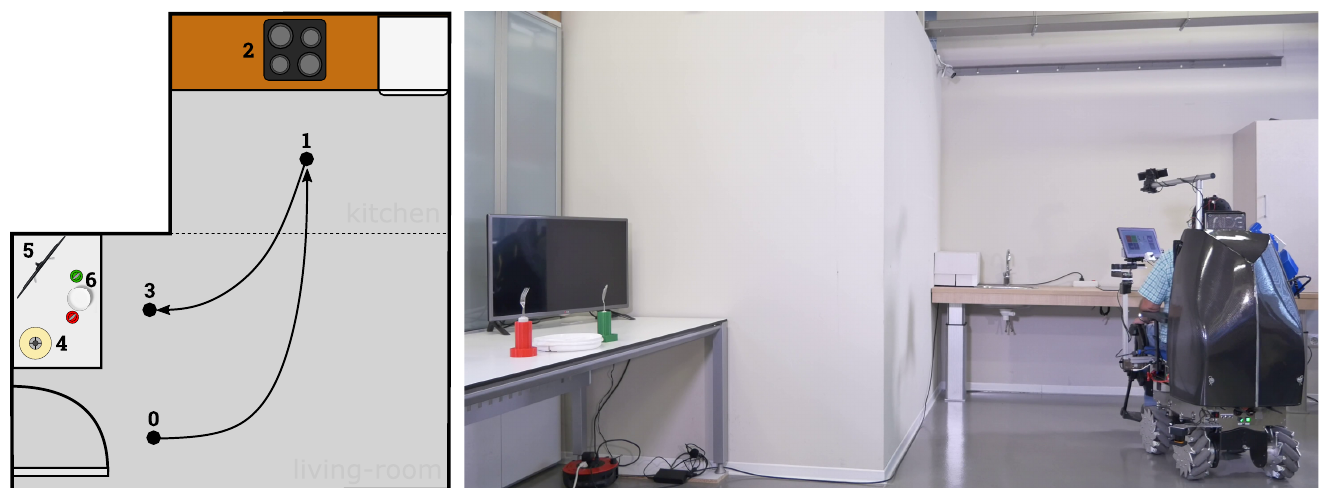
Figure 9. Simulated home